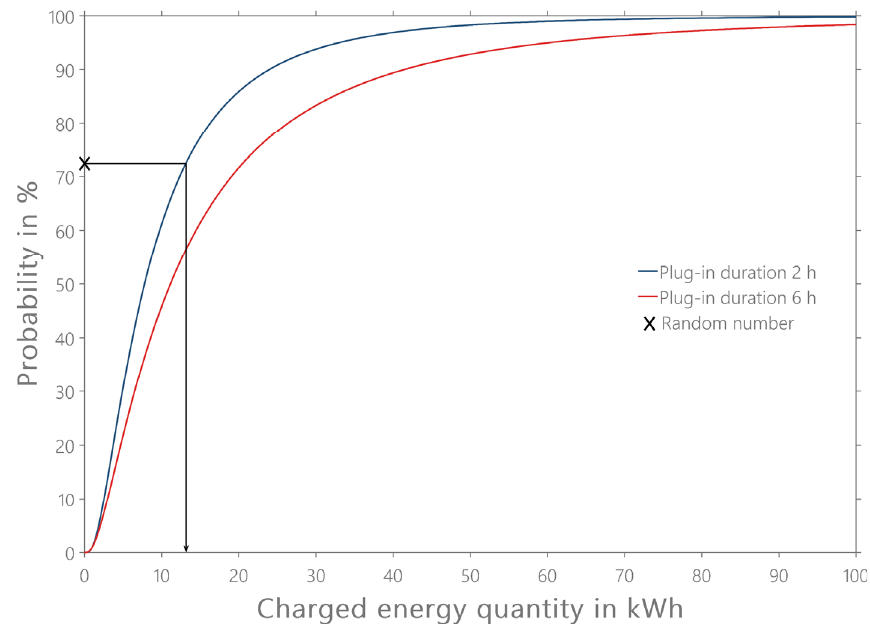
Figure 15. Exemplary representation of the process for selecting the charged energy for plug-in durations of two and six hours. durations of two and six